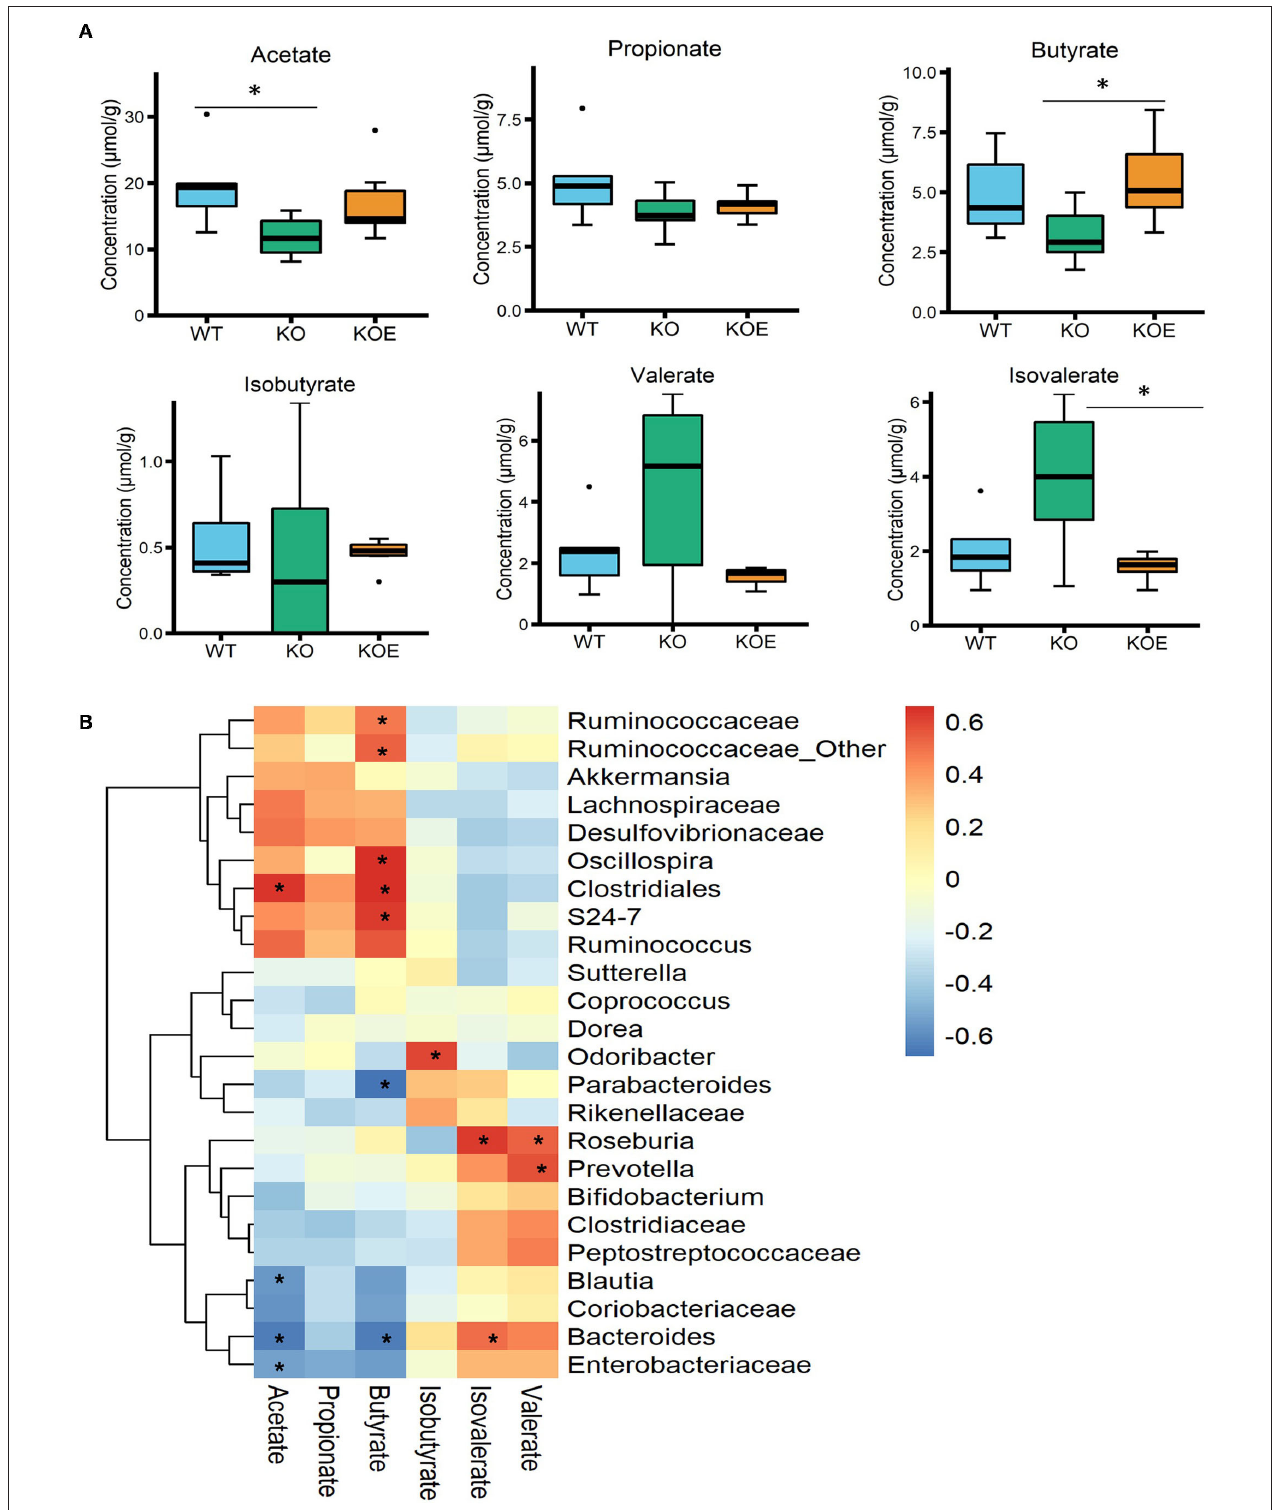
FIGURE 4 | Effects of eggshell membrane (ESM) on the (A) levels of short-chain fatty acids (SCFAs) in cecal contents [wild-type (WT): n = 8, IL10 − / − (KO) and KO with ESM supplementation (KOE): n = 7, respectively]. (B) The heatmap showing the Pearson correlation between SCFAs and the relative abundance of the selected taxa at the family level. * P < 0.05. The dots (•) in the boxplots indicate outliers.